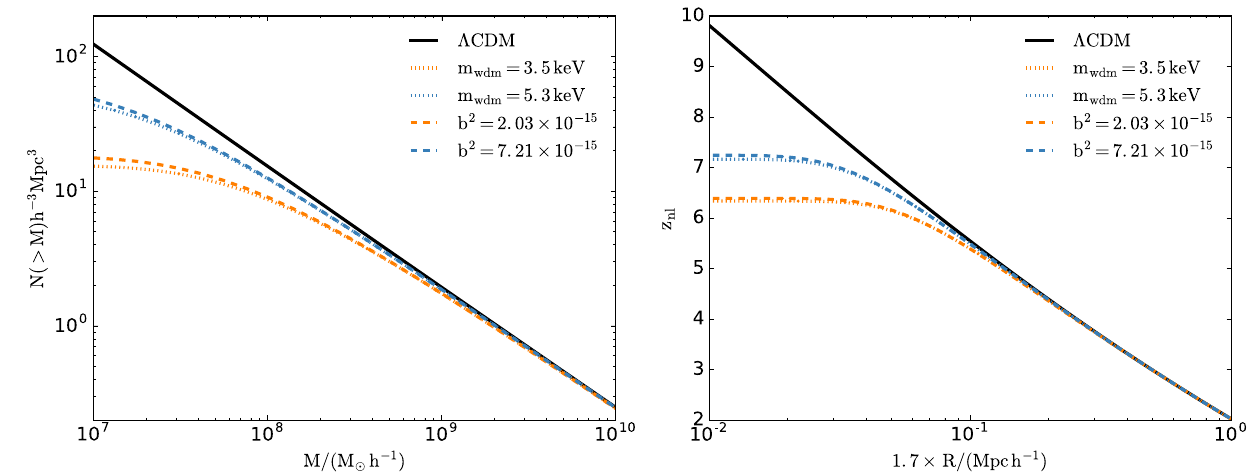
line corresponds to the RRG approach and the dotted line corresponds to WDM case (thermal relics) with mass 3 . 5 and